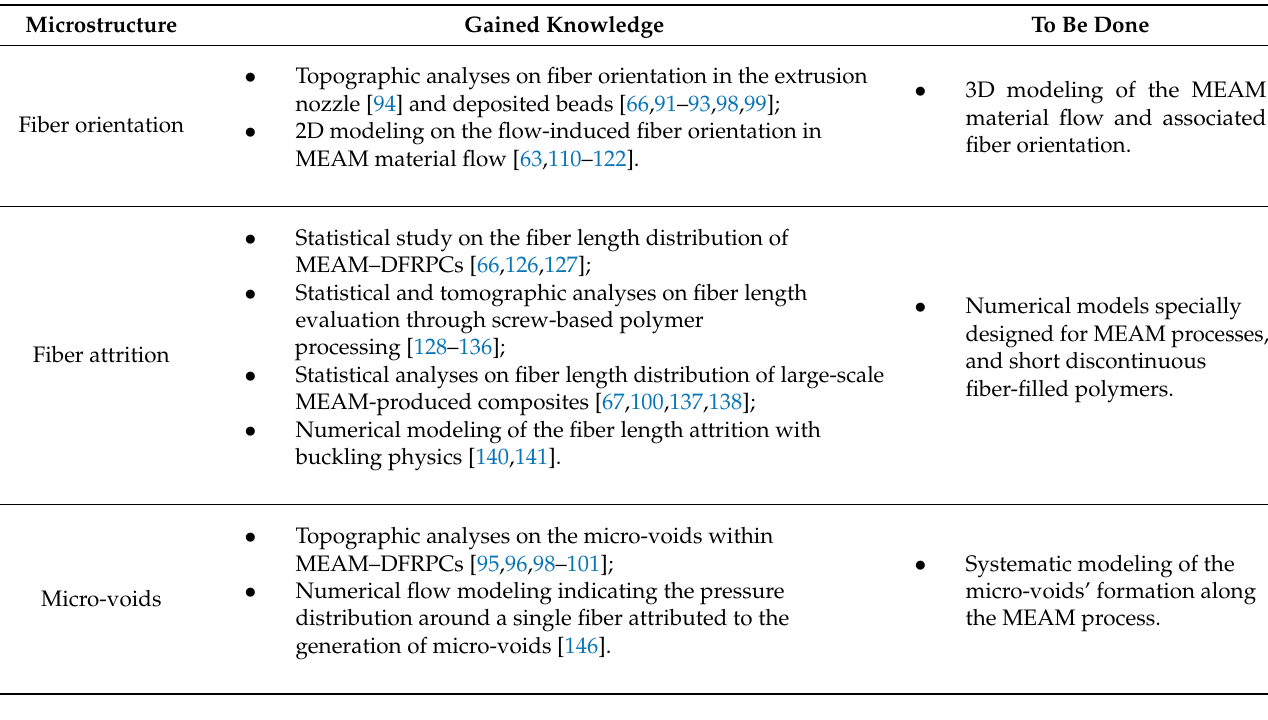
Table 2. Micro-structural formation studies of MEAM–DFRPCs.